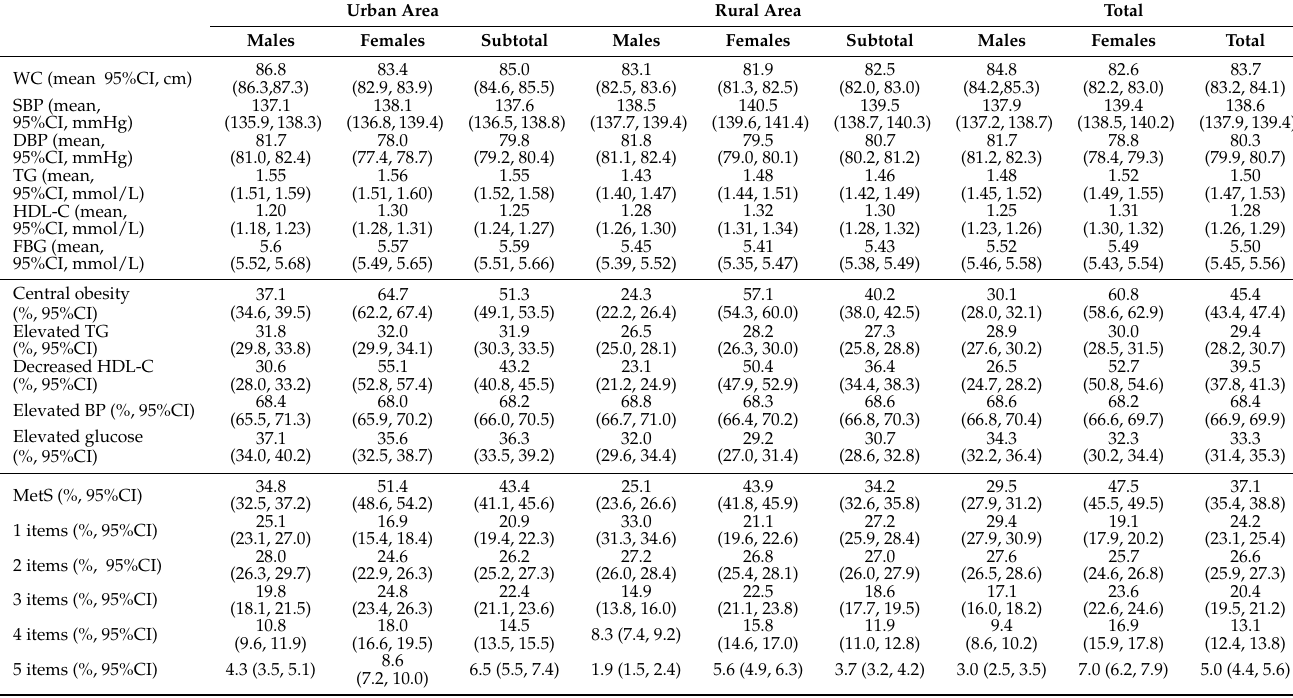
Table 2. Indicators of MetS and its components prevalence among the participants aged 45 y and above in the survey.